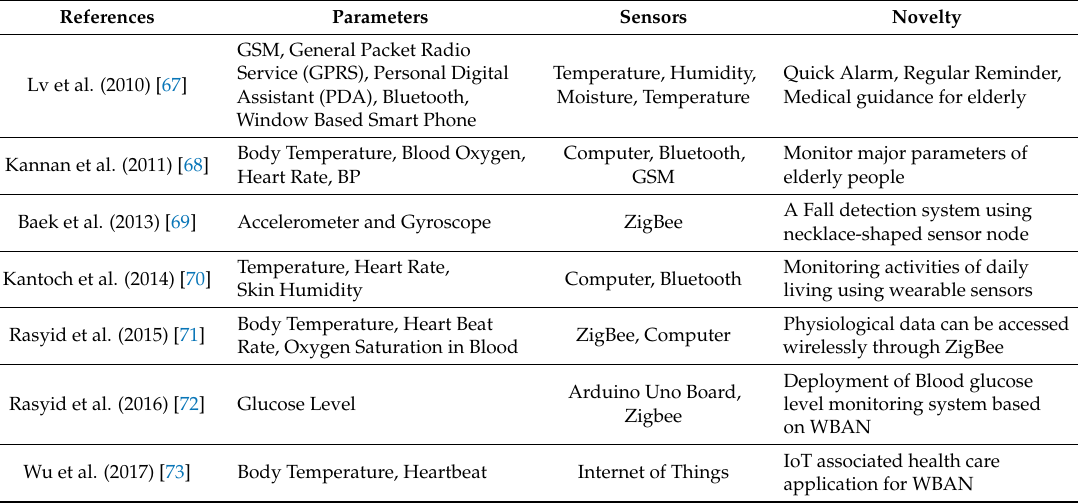
Table 9. Examples of prototyped applications for WBAN (Wireless Body Area Network). GPRS: General Packet Radio Service; PDA: Personal Digital